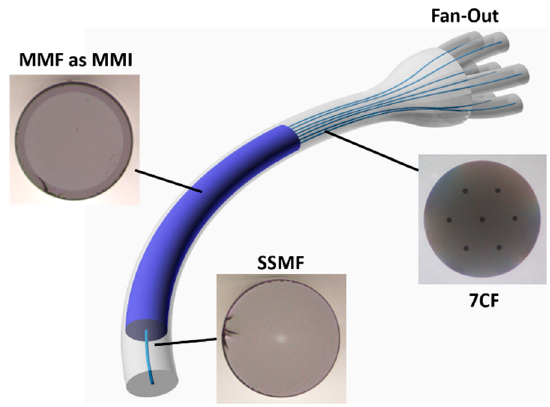
Figure 1. Layout of the vector bend sensor using a standard single mode fiber and a multimode fiber as MMI imaging device. The 7CF and the fan-out device are used to tap out the MMI image for